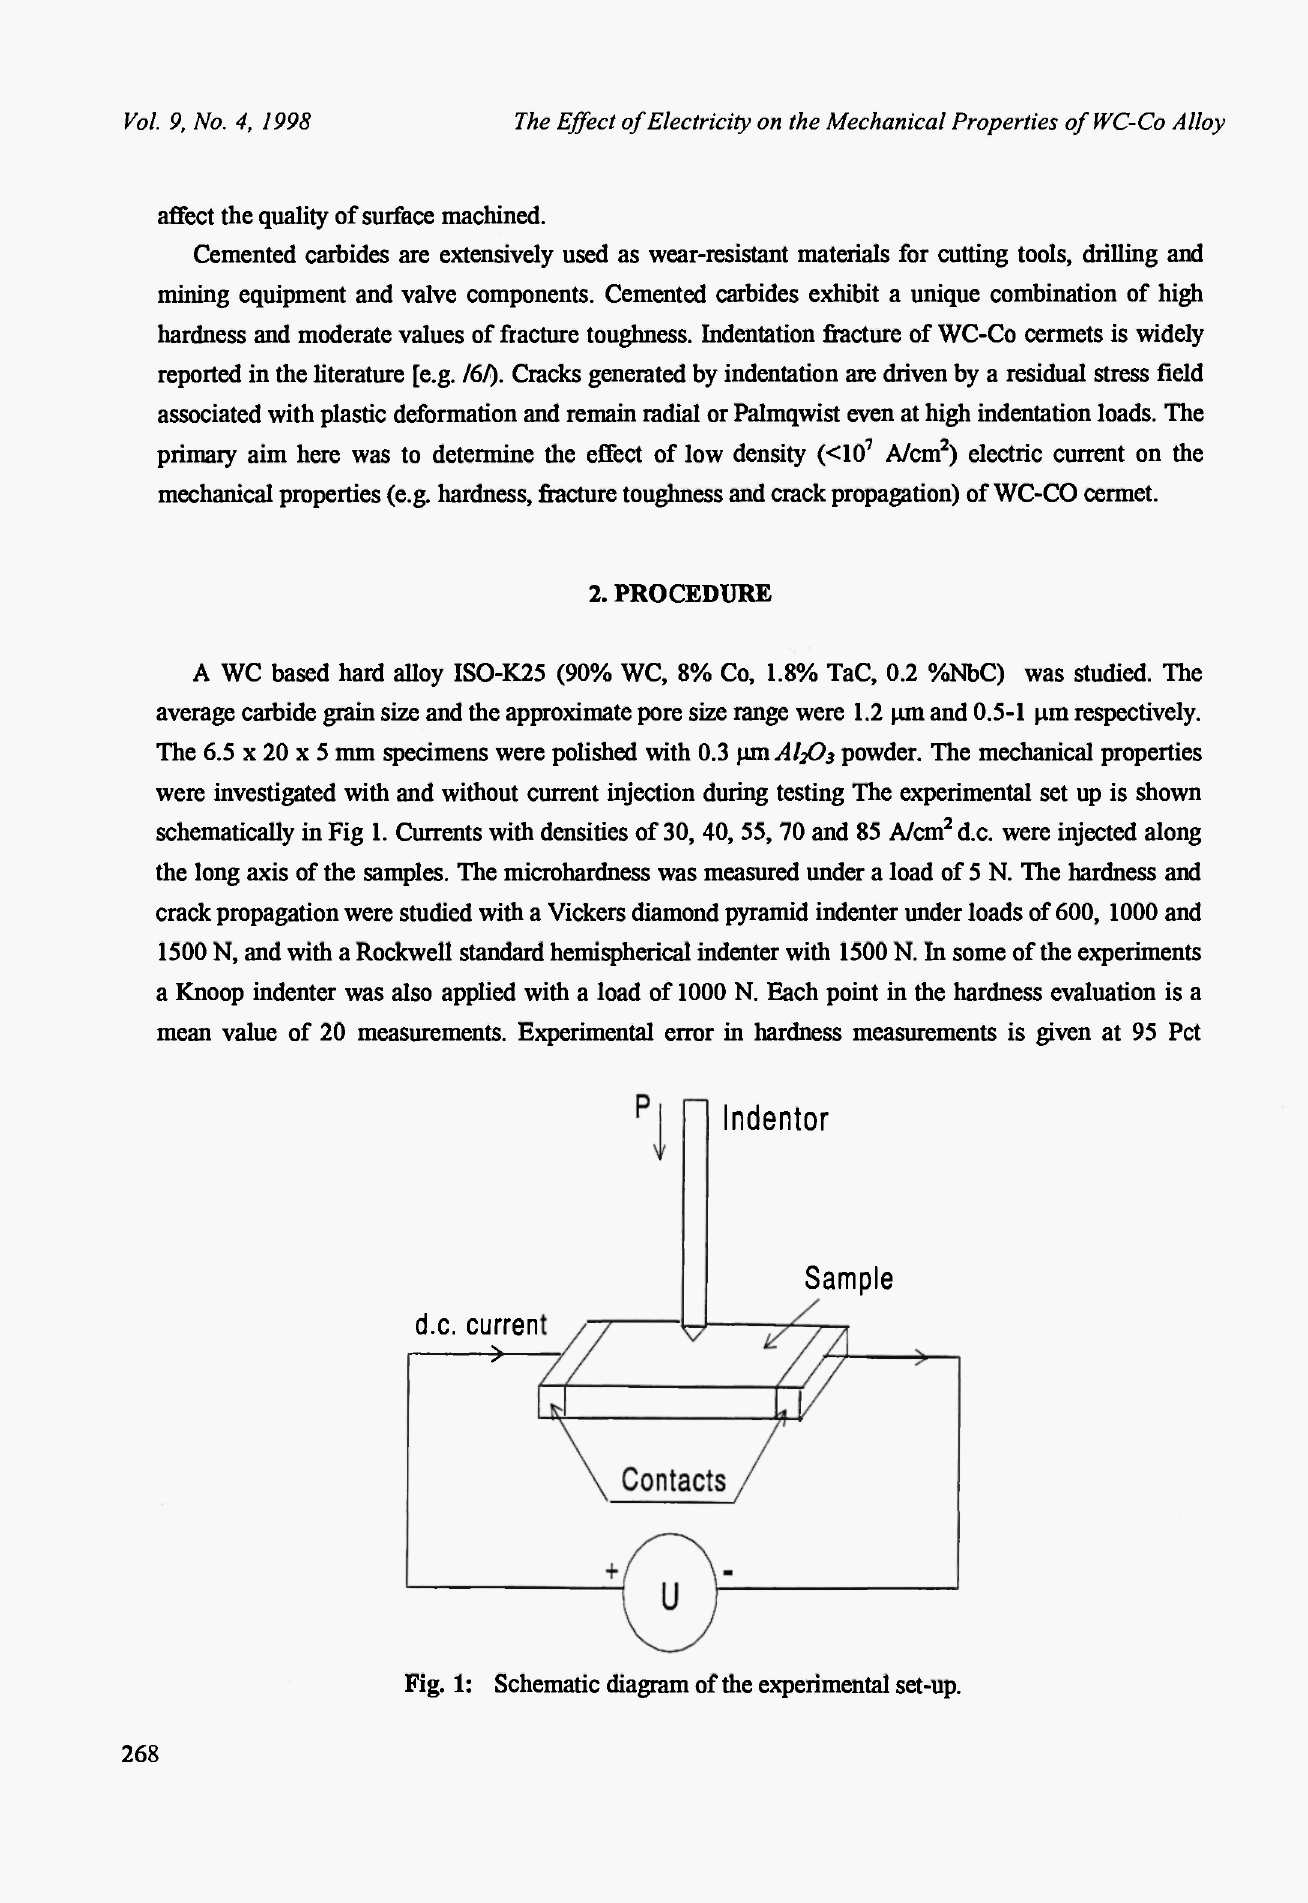
Fig. 1: Schematic diagram of the experimental